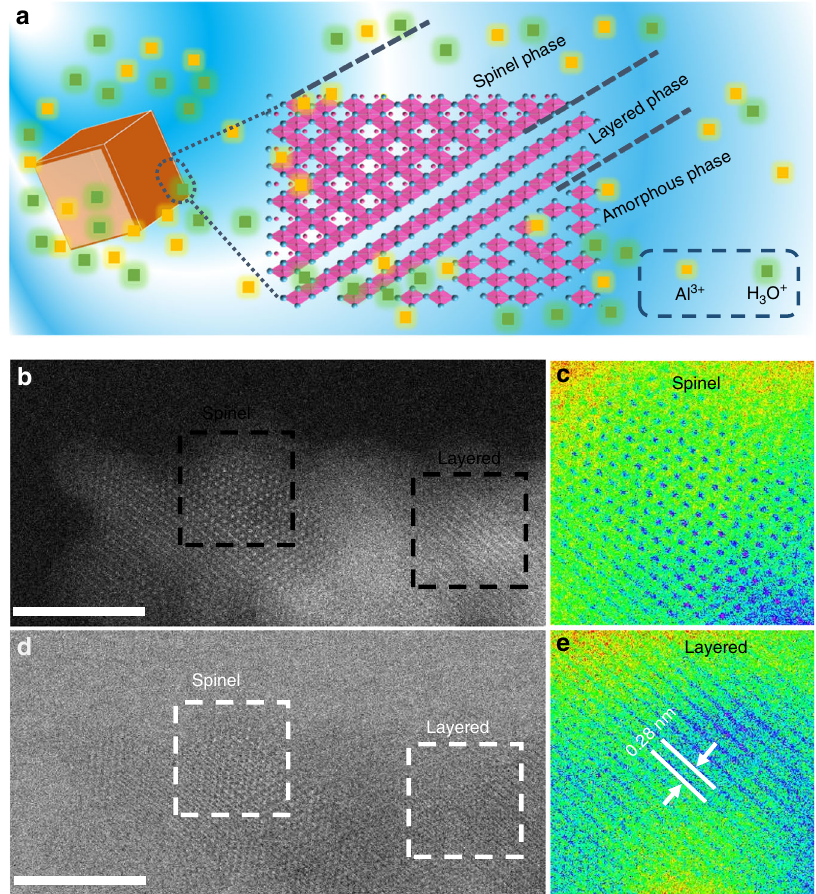
Fig. 3 Schematic pro fi le of the mix phase structure of Al x MnO 2 · n H 2 O. a The schematic pro fi le of the structure of Al x MnO 2 · n H 2 O. b STEM-HAADF image of a thin edge of Al x MnO 2 · n H 2 O. c A false-colored image of the spinel structure areas quoted by white dash line in d . d STEM-ABF image. e A false-colored image of the layered structure areas quoted by white dash line in d . Scale bar: 5 nm for b , d